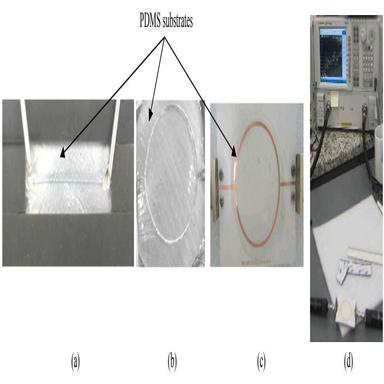
Planar microstrip resonators: hand-made linear (LR) (a) and ring (RR) (b) resonators on PDMS substrate; the metal layout is made by a high-quality selfadhesive aluminium foil; (c) PDMS sample covers a ring resonator on commercial Ro3003 substrate; (d) measurement scheme by VNA in the frequency range 0.01–40 GHz.